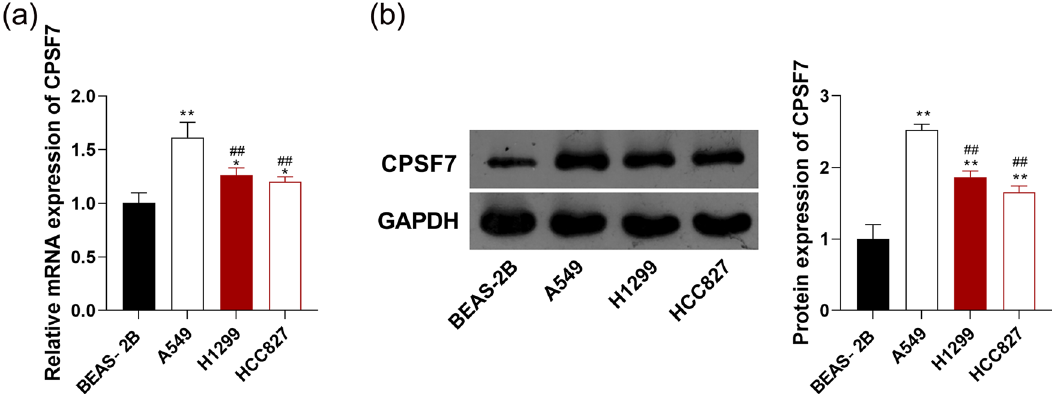
Figure 1: The expression of CPSF7 in three LUAD cell lines ( A549, H1299, and HCC827 ) and a normal lung epithelial cell line ( BEAS ‐ 2B ) . ( a ) mRNA expression of CPSF7 was measured by RT - qPCR; ( b ) protein expression of CPSF7 was measured by Western blotting. Each experiment was repeated three times ( n = 3 ) . * P < 0.05; ** P < 0.01 vs BEAS - 2B; ## P < 0.01 vs